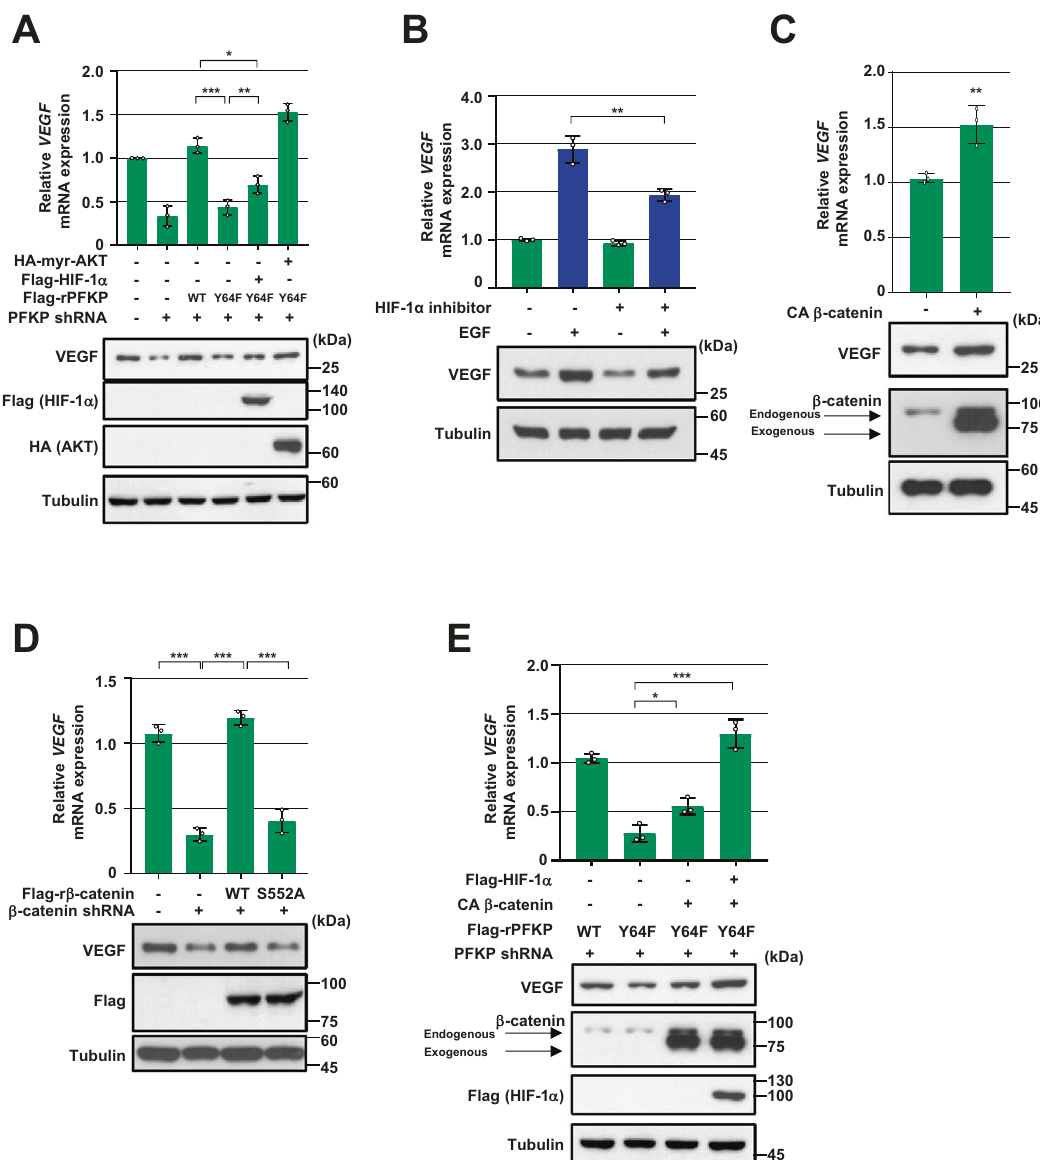
Fig. 3 PFKP Y64 phosphorylation induces VEGF expression through HIF-1 α expression and β -catenin Ser552 phosphorylation in response to EGFR activation. WB and qRT-PCR were performed with indicated primers and antibodies, respectively ( A – E ). A LN229/EGFRvIII cells with or without PFKP depletion and with or without reconstituted expression of WT Flag-rPFKP or Flag-rPFKP Y64F mutant were transfected with or without Flag-HIF-1 α and HA-myr-AKT. B Serum starved LN229 cells were pretreated with DMSO or HIF inhibitor (10 μ M) for 1 h and then treated with EGF (100 ng/mL) for 12 h. C LN229 cells were transfected with a control vector or CA β -catenin. D LN229/EGFRvIII cells with stable expression of β -catenin shRNA or a control shRNA were reconstituted with or without WT r β -catenin or r β -catenin S552A mutant. E PFKP-depleted LN229/EGFRvIII cells with or without reconstituted expression of WT Flag-rPFKP or Flag-rPFKP Y64F mutant were transfected with or without CA β -catenin and Flag- HIF-1 α . Data are presented as mean ± standard deviation of three independent experiments ( A – E ). ** P < 0.01; *** P < 0.001, based on the Student ’ s t -test or one-way ANOVA with Tukey ’ s post hoc test. cells was not altered by VEGF stimulation (Fig. 5D and and Supplementary Fig. S5A), lactate secretion (Fig. 5B and Supplementary Fig. S5D). However, VEGF strongly upregulated Supplementary Fig. S5B), and proliferation (Fig. 5C and Supple- PFKP expression in several GBM cells, including GSCs, LN229, mentary Fig. S5C) in GSCs, LN229, and A172 cells. To investigate A172, LN18, U373MG, and T98G cells (Fig. 5D, Supplementary Fig. which enzymes were regulated in GBM cells during VEGF- enhanced aerobic glycolysis, we analyzed protein expression pro fi les of glycolytic enzymes using immunoblotting. Protein expression levels of glycolytic enzymes, including hexokinase 2 (HK2), PFKM, PFK2, aldolase, glyceraldehyde 3-phosphate dehy- drogenase (GAPDH), phosphoglycerate kinase 1 (PGK1), phospho- glycerate mutase 1 (PGAM1), enolase, pyruvate kinase M2 (PKM2), and lactate dehydrogenase A (LDHA) in GSCs, LN229, and A172